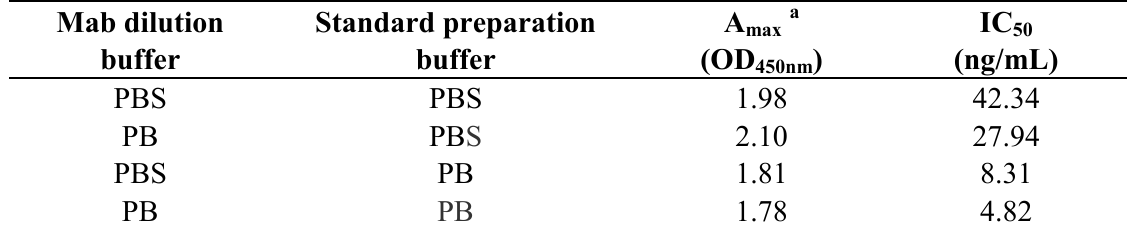
and IC values of ABM standard curves in different incubation Table 3. A max 50